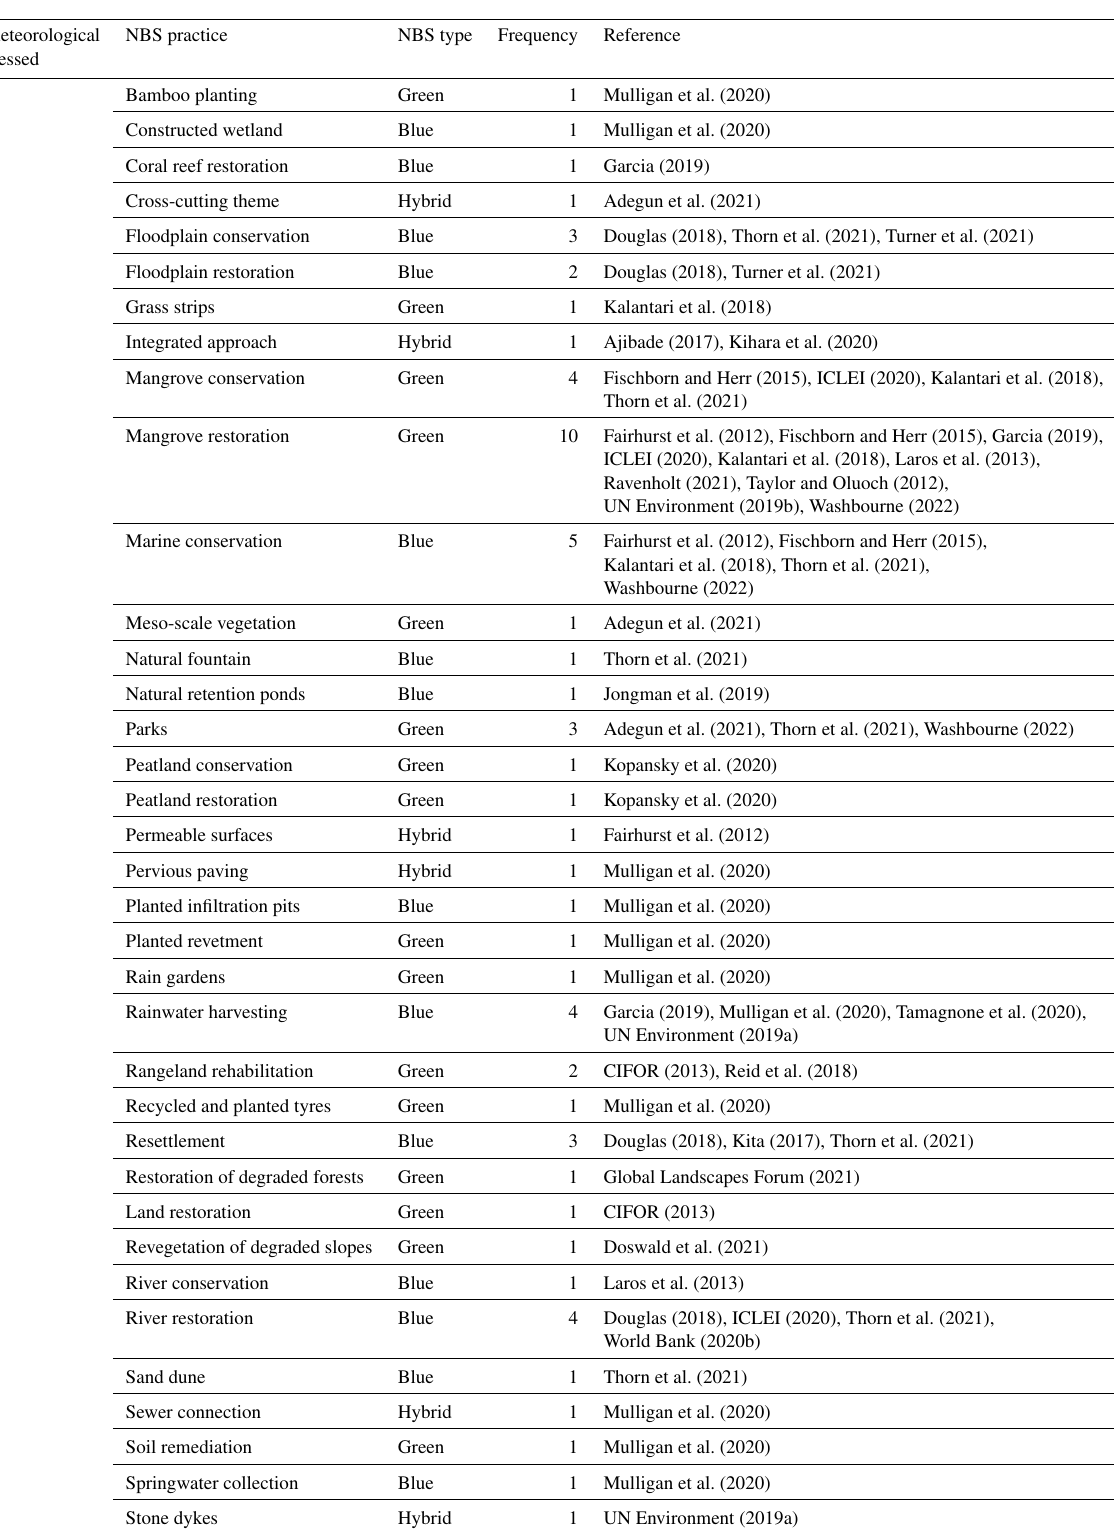
Table 3. List of NBS types and practices used for mitigating floods, extreme heat and drought in SSA and their frequency and sources. (Green NBSs are vegetation-based; blue NBSs are water-based; hybrid NBSs combine green and blue NBS within constructed/grey structures.)